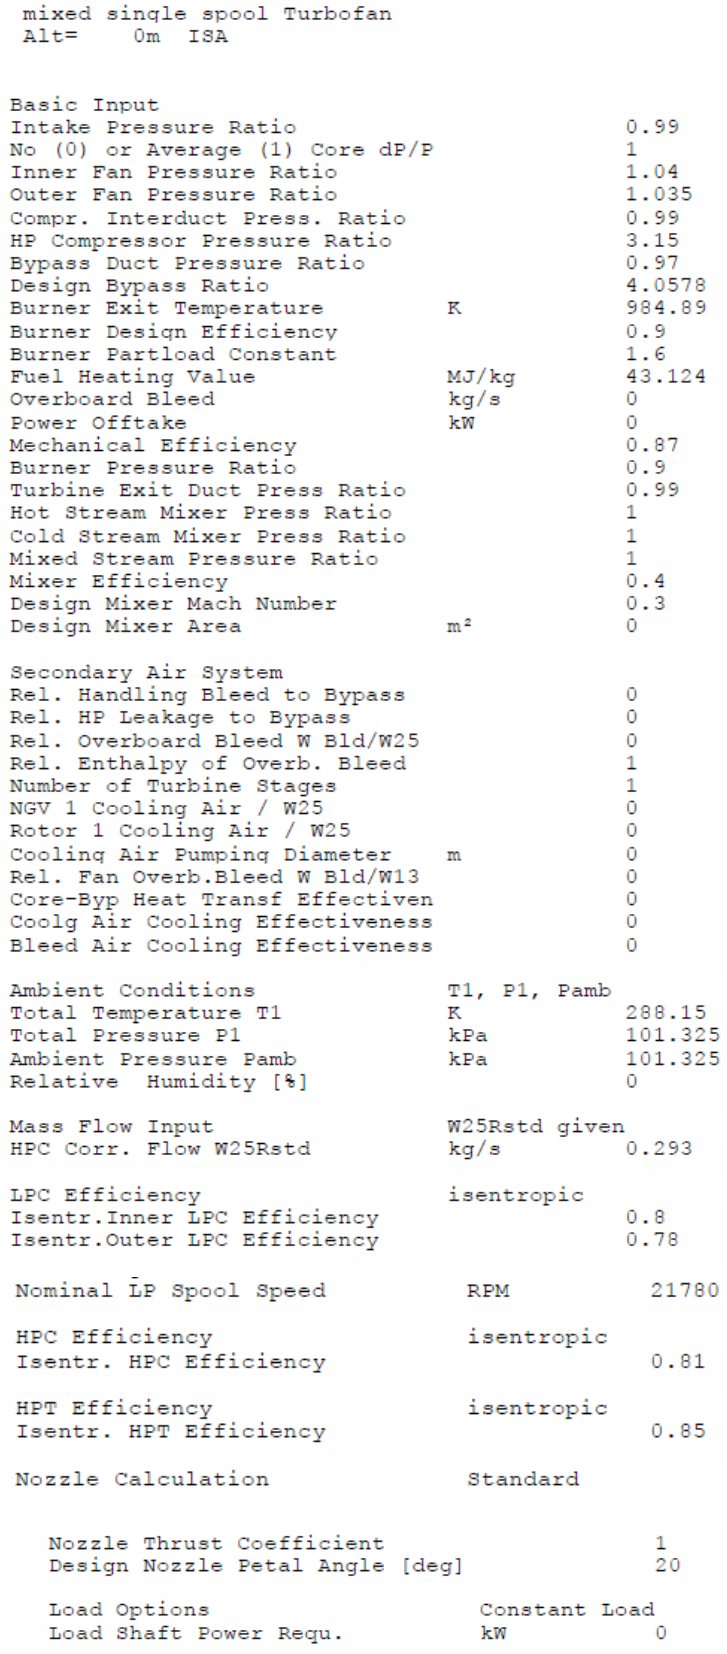
Figure A8. GasTurb Turbofan engine model input parameters—fan at 21,780 RPM.